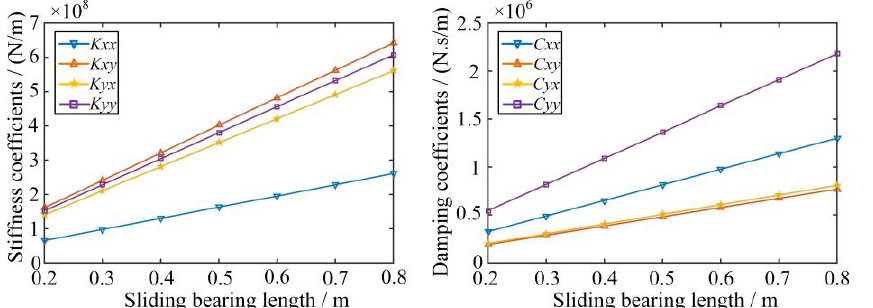
11 of 19 Figure 5. Real structure of the studied sliding bearing. Table 1. Dynamic characteristic coefficients of the sliding bearing. Stiffness Coefficients (×10 7 N/m)